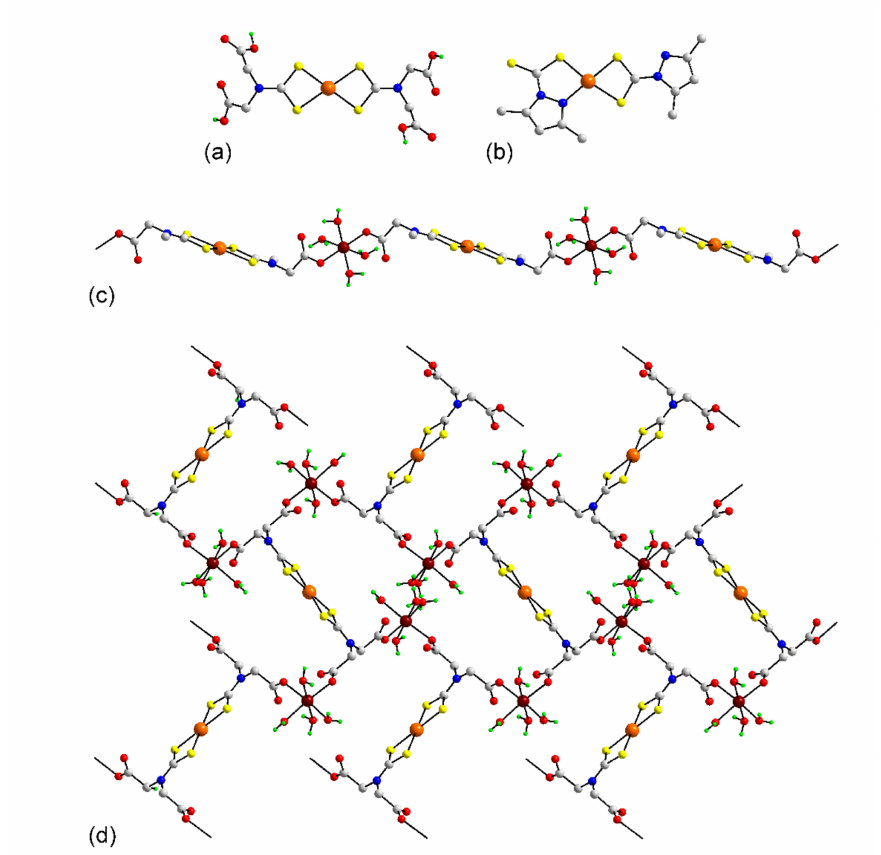
Figure 12. Molecular structures of platinum dithiocarbamate complexes: ( a ) Pt( L 52 ) 2 ( 222 ) and ( b ) Pt( L 62 ) 2 ( 228 ), and coordination polymers in ( c ) [Zn(H 2 O) 4 Pt( L 17 ) 2 ] n in the crystal of 229 and